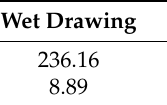
Table 3. Void structure of PAN